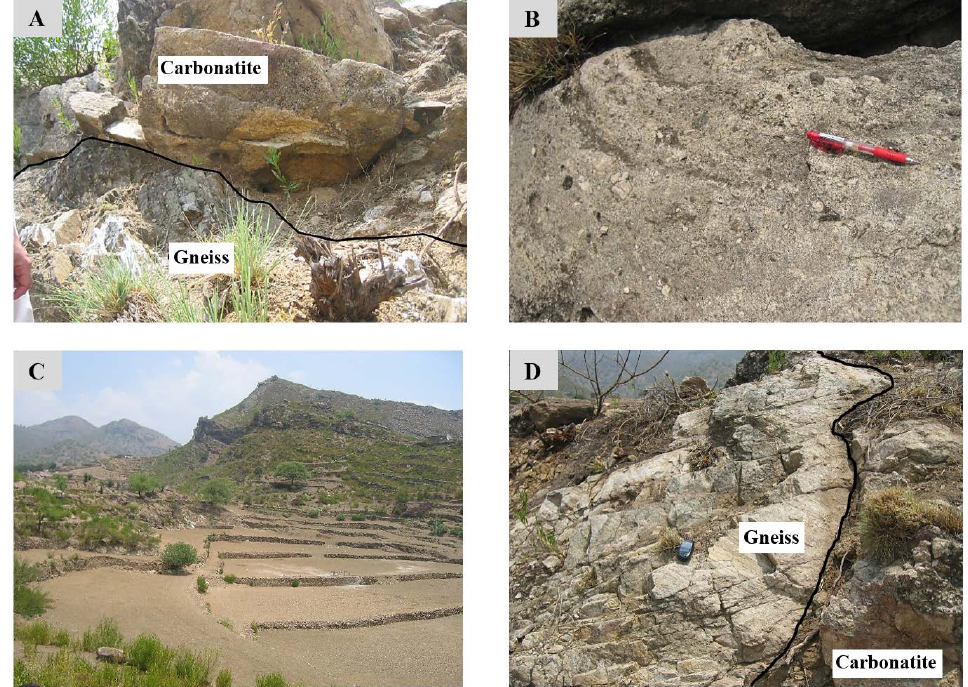
Figure 3. ( A ) Sillai Patti carbonatite (above) in faulted contact with gneiss of probable 510 Ma age; ( B ) typical exposure of the Sillai Patti carbonatite, amphibole is dark-colored and altered while the carbonate are light-colored; ( C ) carbonatite outcrop from a distance; ( D ) carbonatite in contact with gneiss.